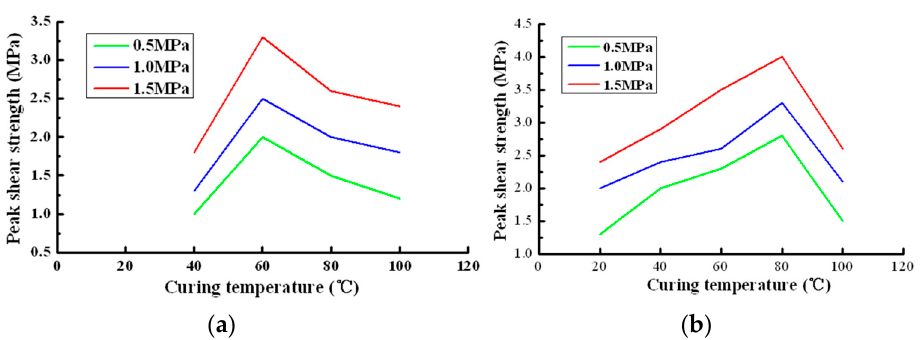
Figure 15. Variation trend of peak shear stress of C30 concrete with temperature: ( a ) 55% RH and ( b ) 95% RH [86].